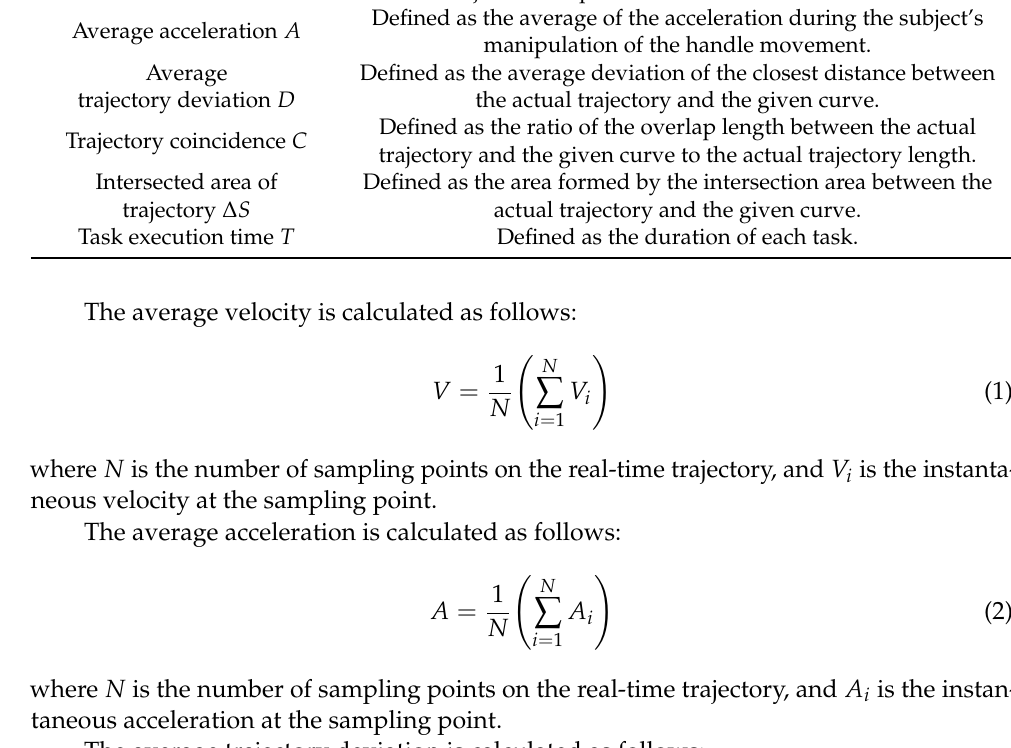
Table 2. Feature parameters that characterize the motor function. Feature Parameters Defined as the number of points on the velocity curve where the instantaneous velocity value is larger than the average velocity. Defined as the average of the instantaneous velocity during the subject’s manipulation of the handle movement. Defined as the average of the acceleration during the subject’s manipulation of the handle movement. Defined as the average deviation of the closest distance between trajectory deviation D the actual trajectory and the given curve. Defined as the ratio of the overlap length between the actual Trajectory coincidence C trajectory and the given curve to the actual trajectory length. Defined as the area formed by the intersection area between the trajectory ∆ S actual trajectory and the given curve. Task execution time T Defined as the duration of each